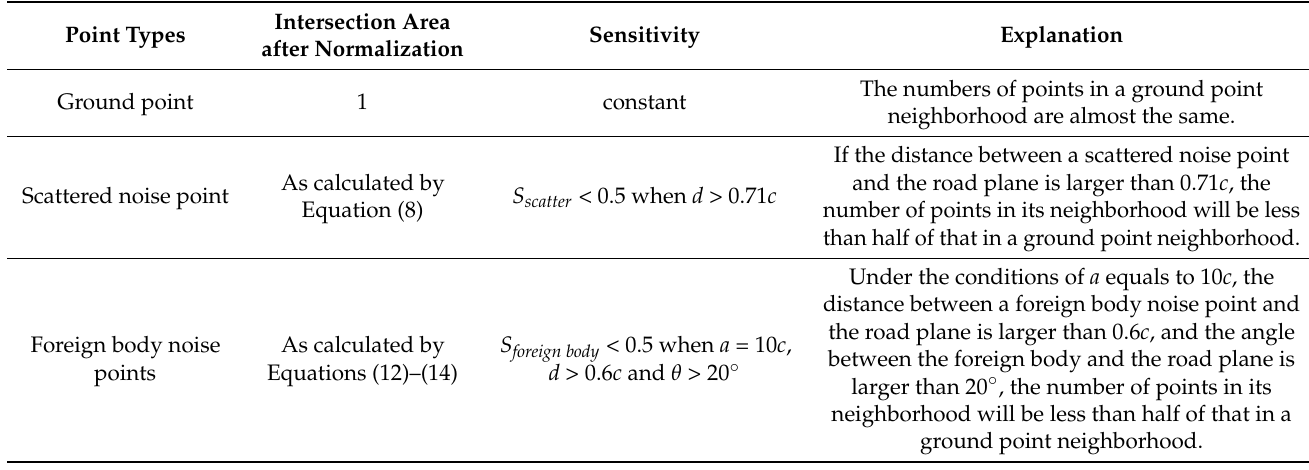
Table 1. The intersection area in the ellipsoid neighborhood of different types of